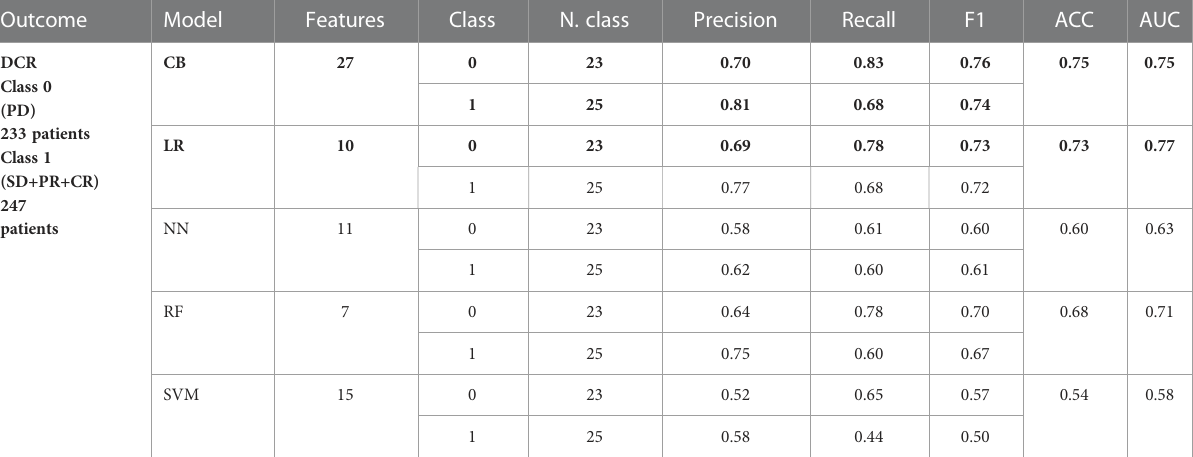
TABLE 3 Performance of classi fi cation models on the test dataset; outcome – DCR. Outcome